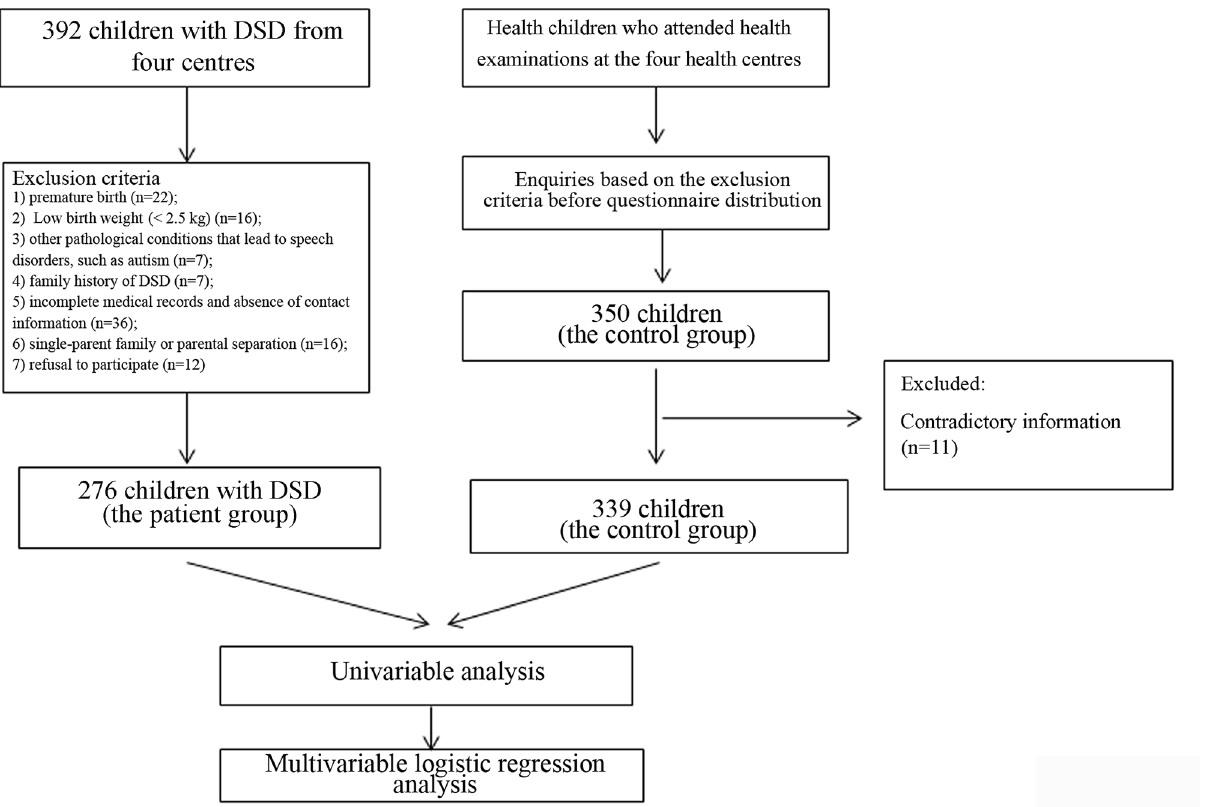
Figure 1. Fluxogram of participant recruitment in this